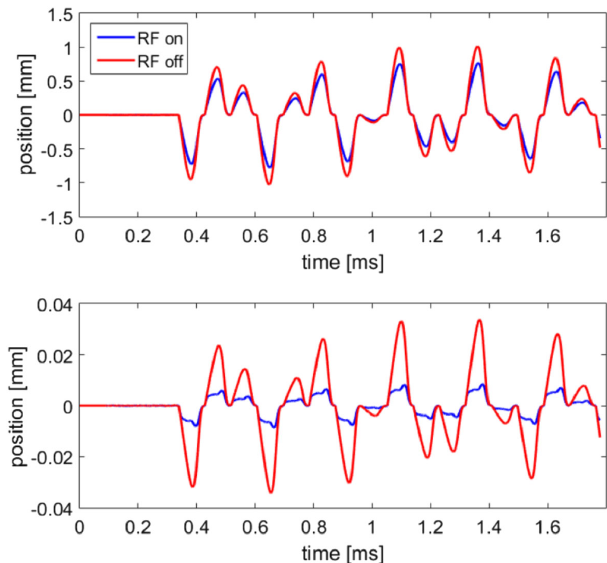
FIG. 13. Transverse beam position during a quench in 4K LHe (top) and 2K LHe (bottom) for an HL-LHC cavity, with the rf kept on (blue) or switched off (red) when a quench is